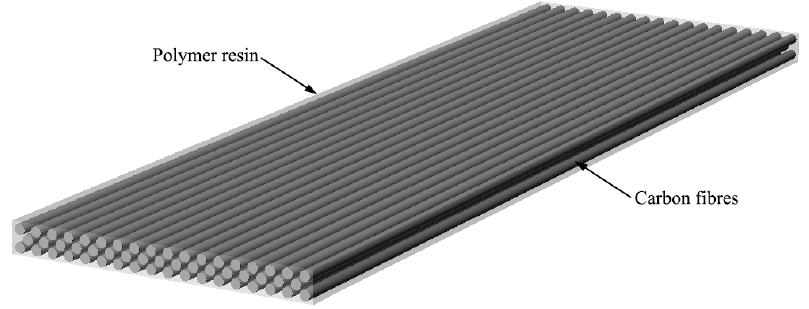
Figure 2. Typical structure of Carbon Fiber Reinforced Polymer (CFRP).